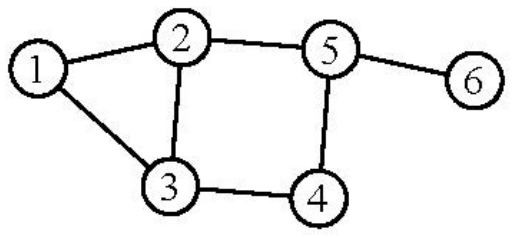
Figure 46: A drawing of a labelled graph on 6 vertices and 7 edges.